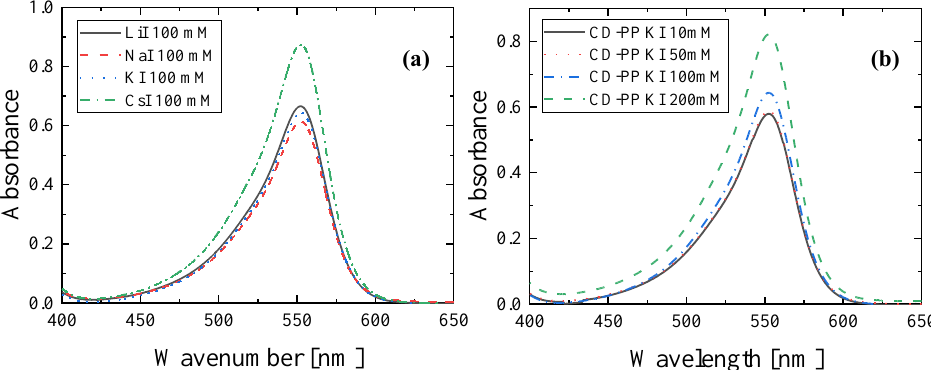
Figure 2. Effect of the alkali-type ( a ) and salt concentration ( b ) on the electronic spectra of the CD–PP solution in the visible region.